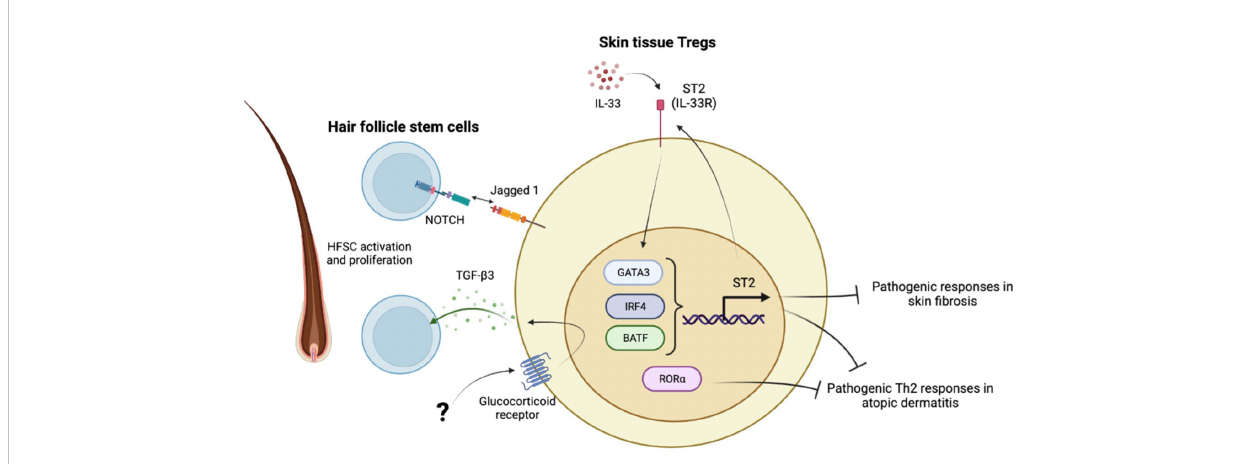
FIGURE 2 Characteristics of skin tissue Tregs. IL-33-ST2 axis maintains skin Treg signature with high GATA3, IRF4, BATF expression. ROR a is highly expressed in skin Tregs. Those transcription factors are critical to provide skin immune tolerance and prevent development of skin fi brosis and atopic dermatitis. The other aspect of skin Tregs is to maintain hair follicle homeostasis through interaction with hair follicle stem cells (HFSCs). Skin Tregs activate and facilitate HFSCs proliferation through Jagged 1-Notch axis and glucocorticoid receptor mediated TGF- b 3 secretion. The upstream mechanisms how GR is activated in the hair follicle is still not